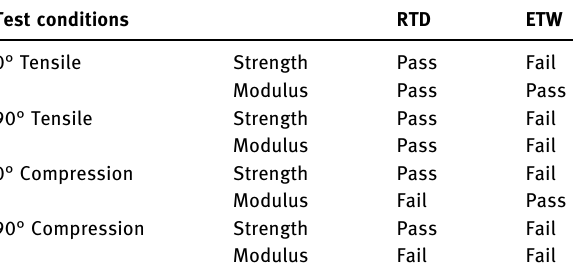
Figure 4. The failure modes of the tensile and compression